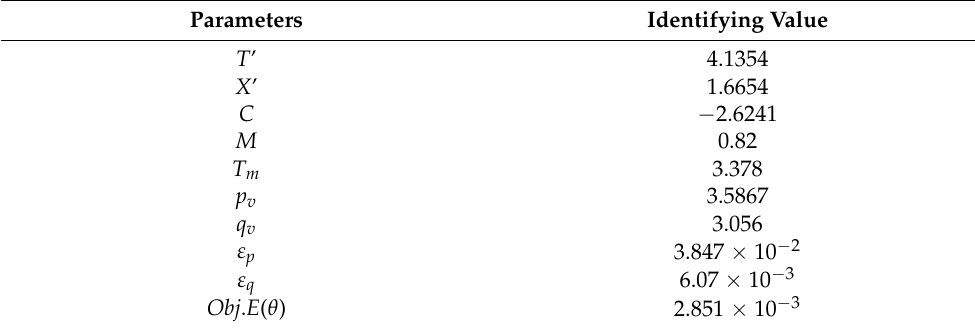
Table 2. Parameter identification values and errors.